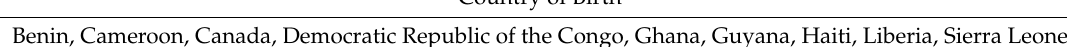
Table 8. African Americans, Born Outside of US ( n = 9). Country of